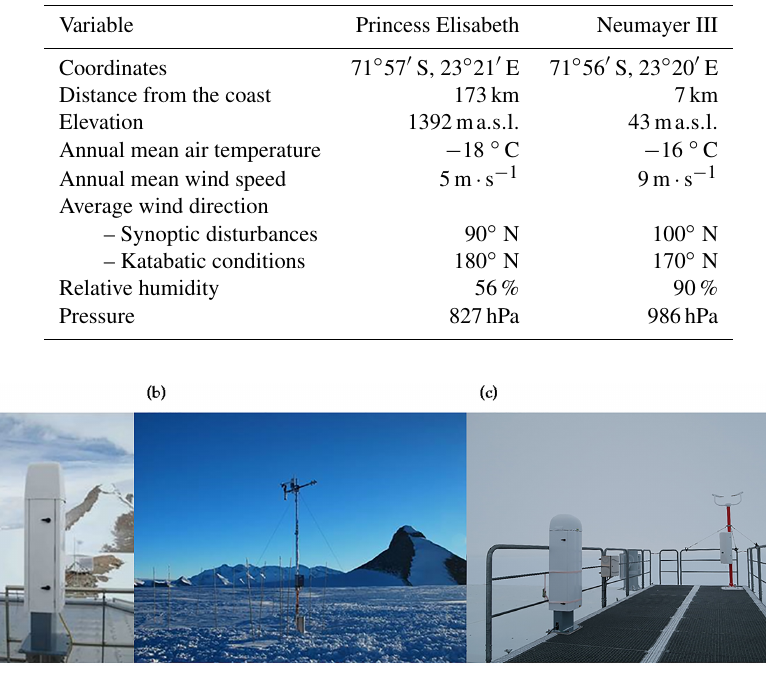
Figure 3. (a) The Vaisala CL-31 ceilometer on the roof of PE station; (b) the IMAU automatic weather station at PE; (c) the Vaisala CL-51 ceilometer on the roof of Neumayer III station (credits: Hauke Schulz).